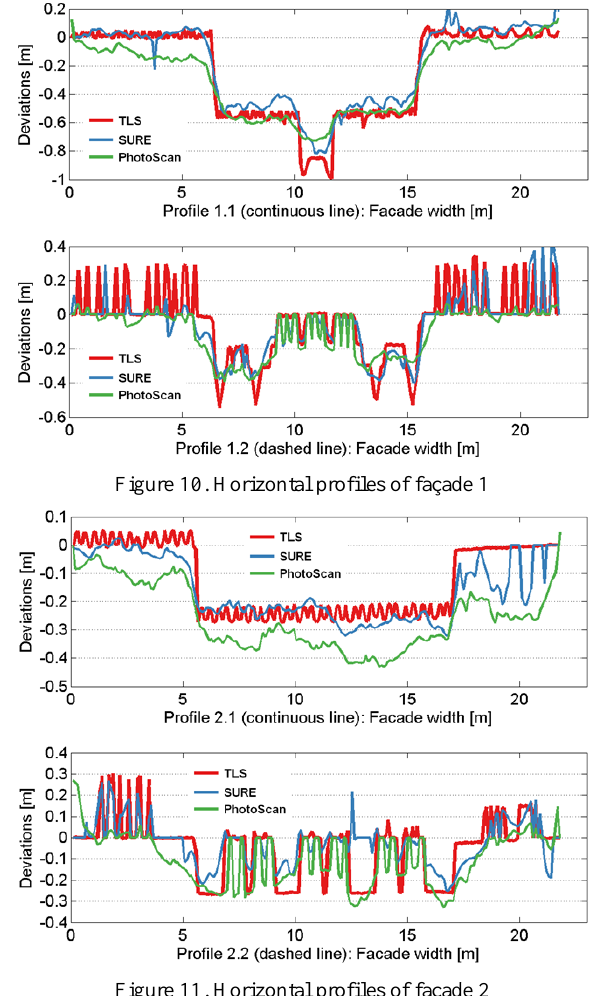
Figure 11. Horizontal profiles of façade 2